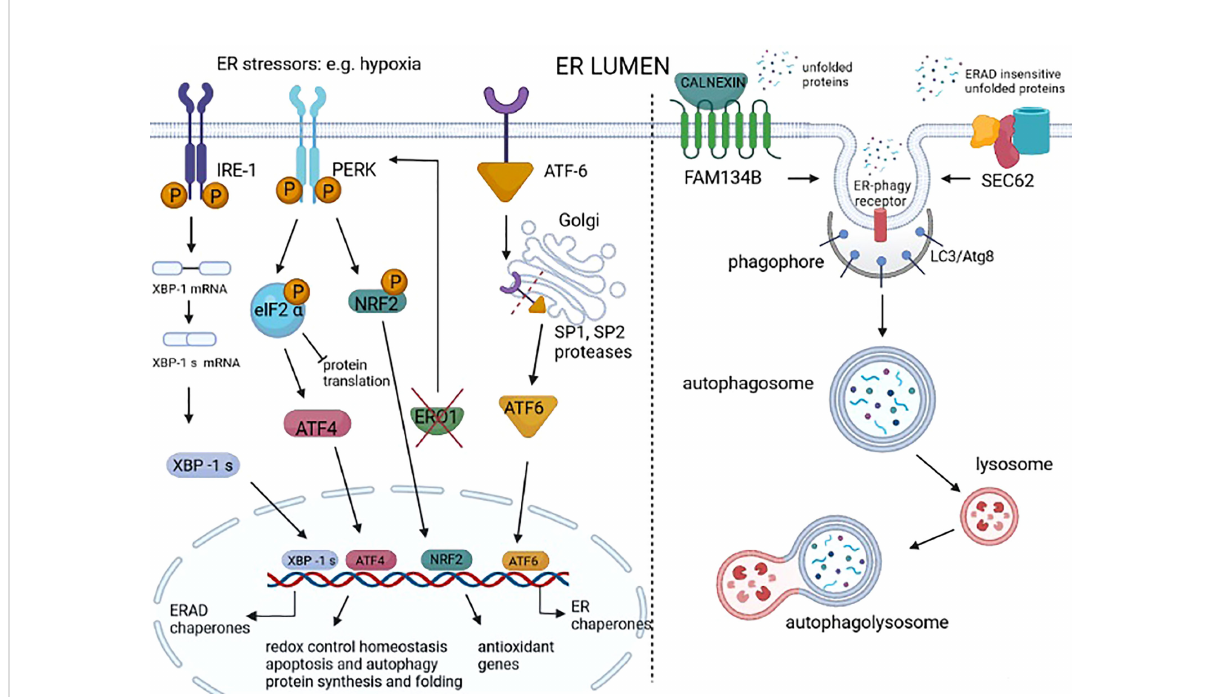
FIGURE 2 Unfolded protein response (UPR) and ER-phagy in cancer. UPR is a homeostatic response to ER stress that is present in many cancer types. UPR is activated by three different sensors on the ER membrane: IRE1, PERK, and ATF6. IRE1 dimerizes following ER stress, activating an RNAse domain that promotes the unconventional splicing of XBP1 mRNA (XBP1s). The translated XBP1s acts as a transcription factor of genes involved in ER-associated degradation (ERAD) and chaperones. ER stress – activated PERK phosphorylates eIF2 alpha, promoting the attenuation of protein translation while also promoting the phosphorylation of NRF2, thereby the transcription of genes with an antioxidant function. The PERK signal also favors the selective translation of ATF4, which regulates the redox control, the genes involved in autophagy, and the CHOP-ERO1 axis. Regarding the axis CHOP-ERO1, we have seen that in breast cancer cells under hypoxic conditions, ERO1 is not downstream to CHOP. However, the lack of ERO1 converges and activates the PERK signal (21). ATF6 translocates in the Golgi where it is cleaved by SP1 and SP2 proteases and acts as a transcription factor of ER chaperones. ER stress also activates ER-phagy, a mechanism that leads to the clearance of ER portions containing misfolded proteins. FAM134B is an ER-phagy receptor that, through a physical interaction with a protein adaptor, such as calnexin, might sense unfolded proteins and starts the autophagy of the ER. SEC62 is another ER-phagy receptor that leads to the ER-phagy of ER portions containing ERAD-insensitive unfolded